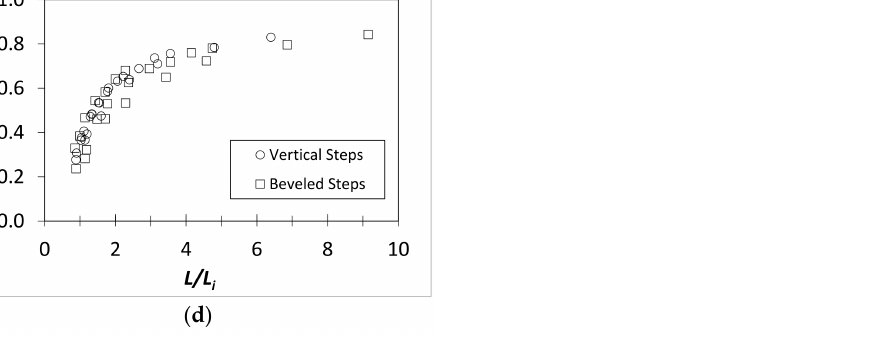
Figure 7. Comparisons of ( a ) relative flow depths ( y / d c , y cw / d c ), ( b ) mean air concentration, C mean , ( c ) y 90 / d c , and ( d ) relative energy loss, ∆ H / H o , for vertical and beveled face